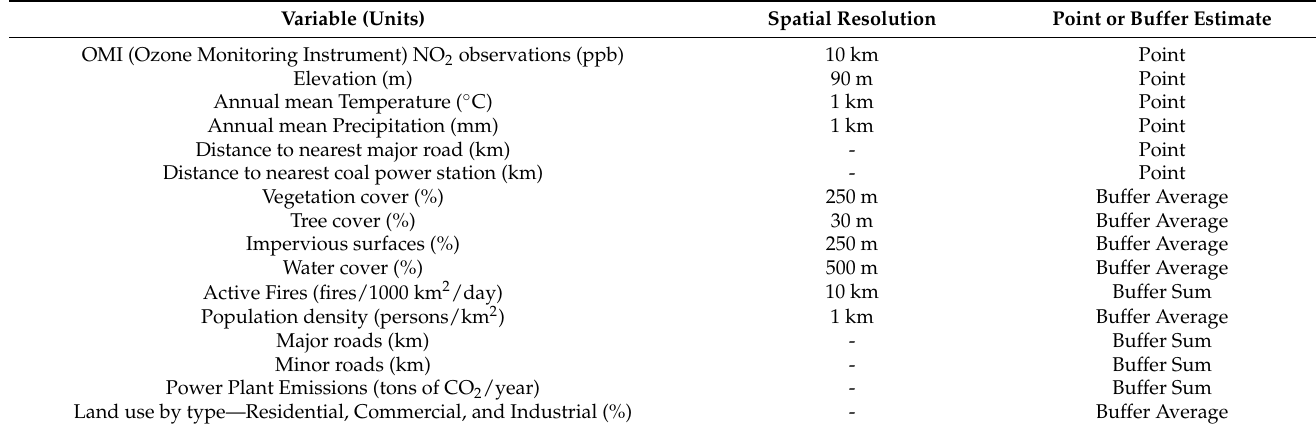
Table 1. Predictor variables included in LUR model development *.